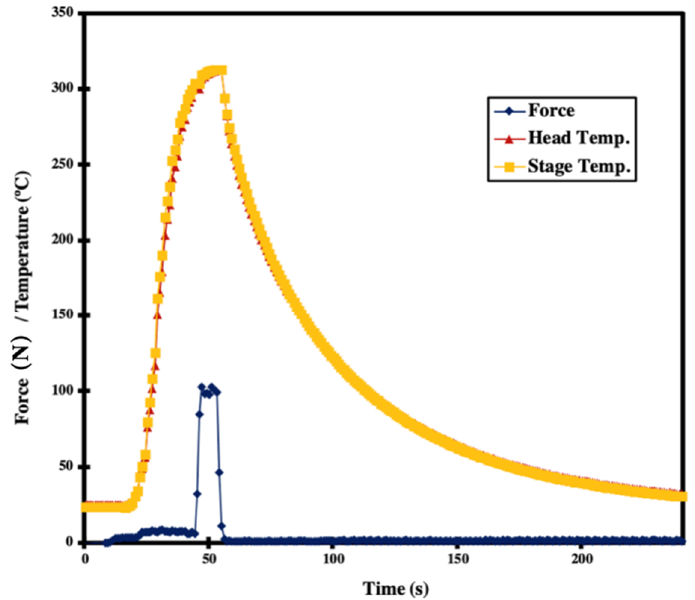
Figure 7. ( a ) Cross-sectional FIB electron and ( b ) ion images of the microbumps bonded under 47 MPa/10 s at 300 °C.